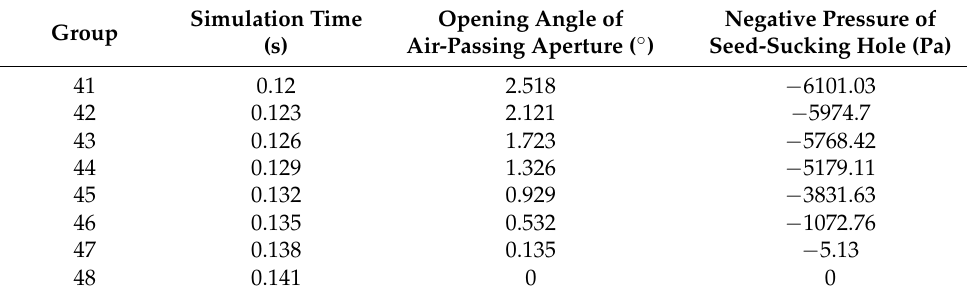
Table 5. Sliding mesh simulation results for groups 41–48.